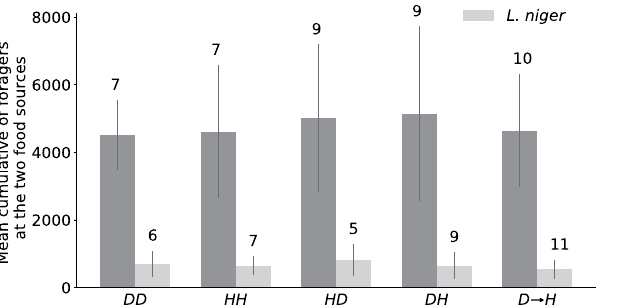
Figure 1. Cumulative number of foragers at the two food sources for 2 h in each condition. Mean and standard deviation; numbers above bars = number of replicates. DD = Down-Down, control condition, two descending paths to food sources. HH = High-High, control condition, two ascending paths to food sources. HD = High- Down, experimental condition, left path ascending to food source and right path descending to food source. DH = Down-High, experimental condition, left path descending to food source and right path ascending to food source. D → H = Down → High, experimental condition, only down food source available at the end of left path during the first 20 min of experiment before incidentally introduction of the high food source at the end of the right branch.